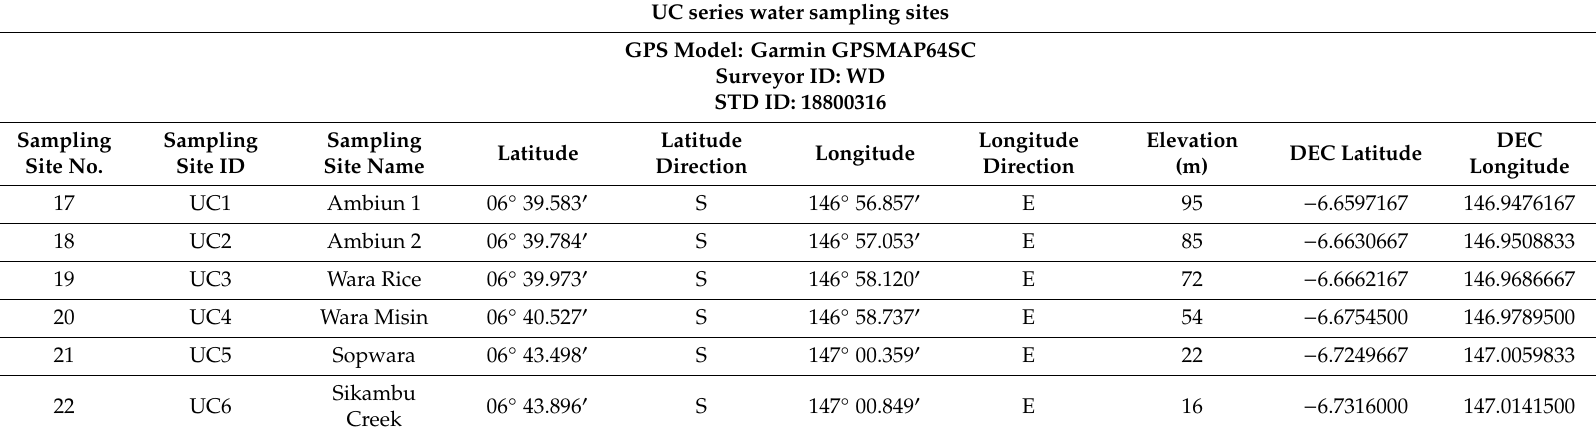
Table A3. GPS survey of the 6 water sampling sites of UC